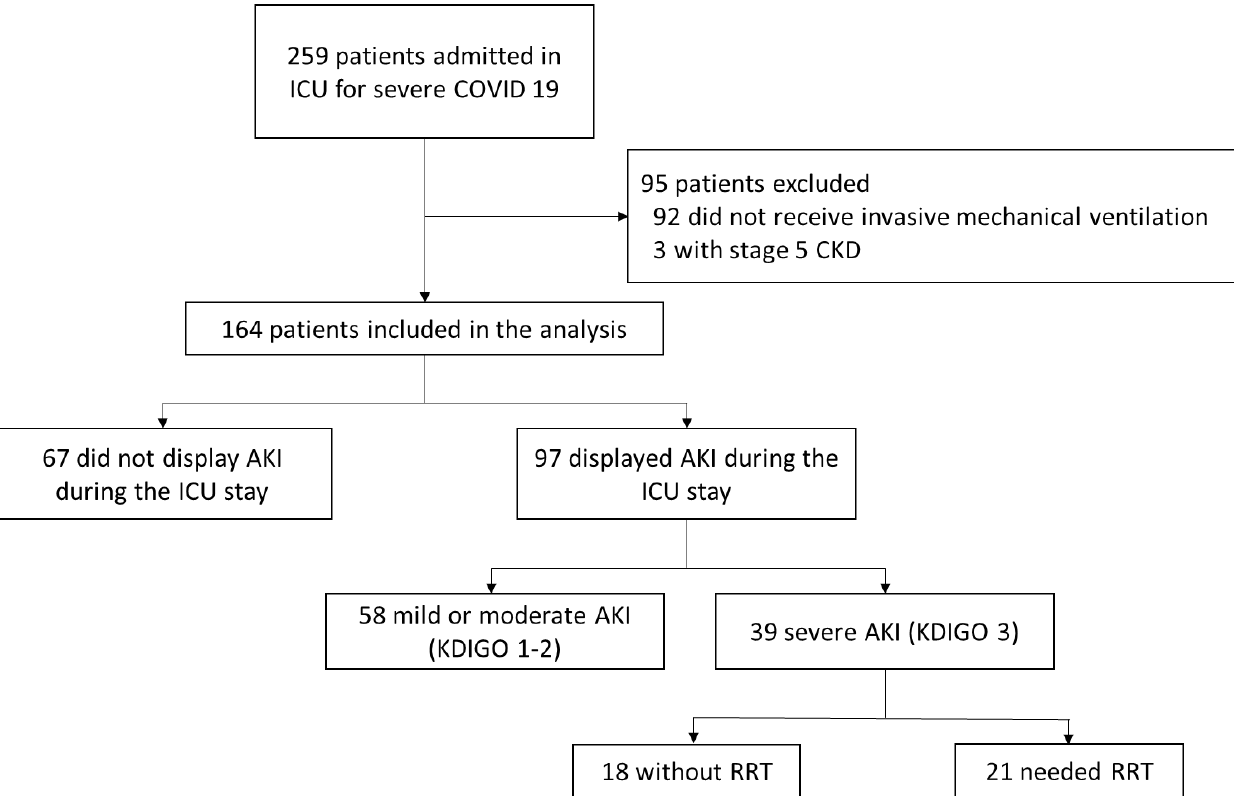
Figure 1. Flow chart of the study. AKI: Acute Kidney Injury, CKD: Chronic Kidney disease, ICU: In- tensive Care Unit, RRT: Renal replacement